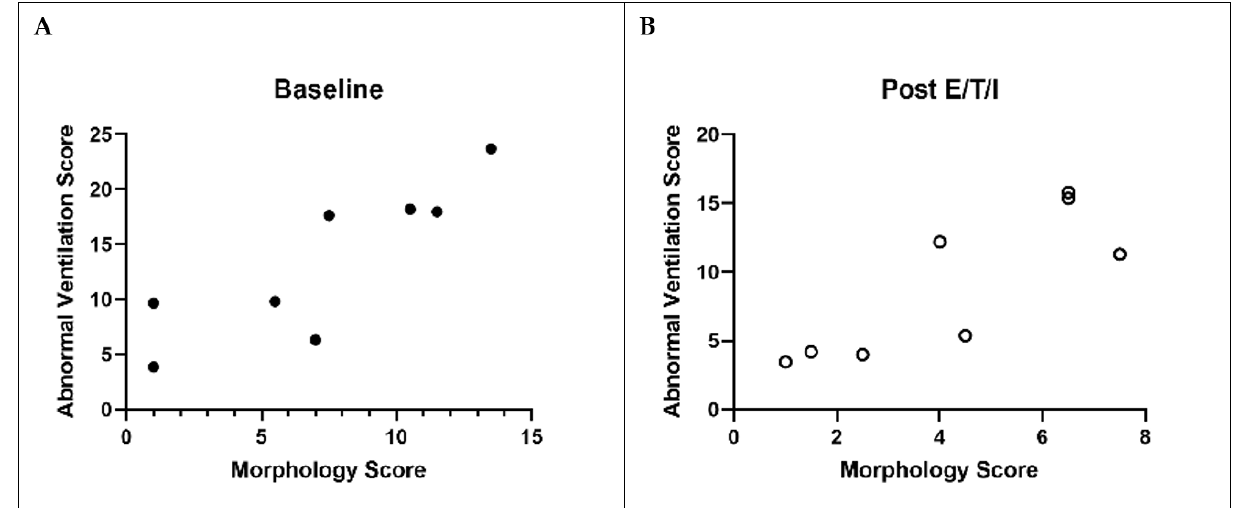
Figure 5. Correlation between lung structure and function before ( A , closed circles) and after ( B , open circles) elexacaftor/tezacaftor/ivacaftor. Correlation between combined abnormal ventilation score with overall morphology score at baseline and post elexacaftor/tezacaftor/ivacaftor. Spearman correlation at baseline: r = 0.89; p = 0.006. Spearman correlation at post elexacaftor/tezacaftor/ivacaftor: r = 0.78; p = 0.03. E/T/I: elexacaftor/tezacaftor/ivacaftor.